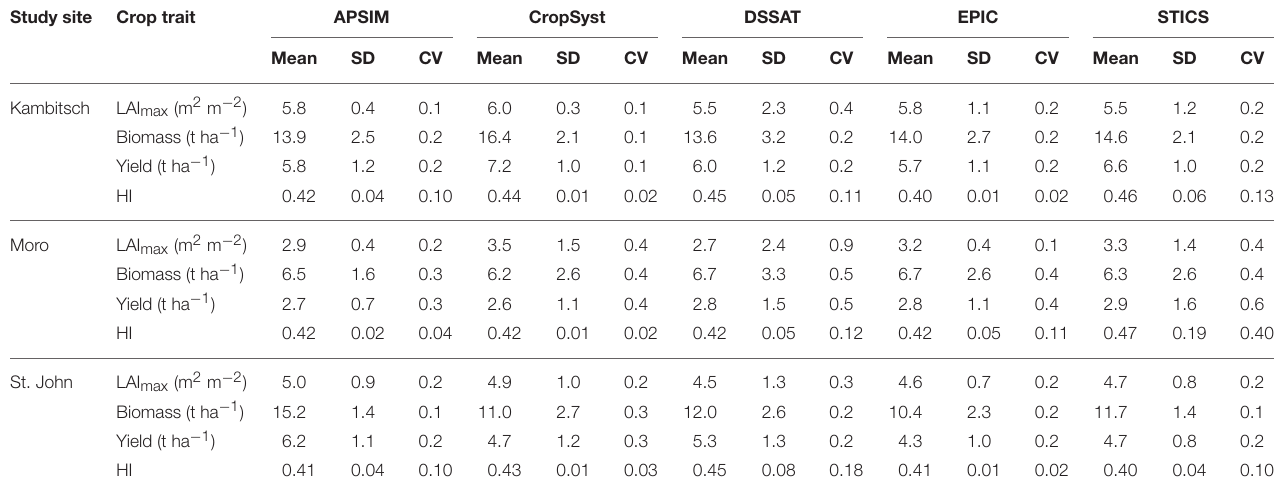
TABLE 5 | Performance of five crop models under historical weather conditions (1979–2010) in simulating mean maximum leaf area index (LAI max ), above-ground biomass, grain yield and harvest index (HI) with standard deviation and coefficient of variation at three sites not used for model calibration in the Pacific